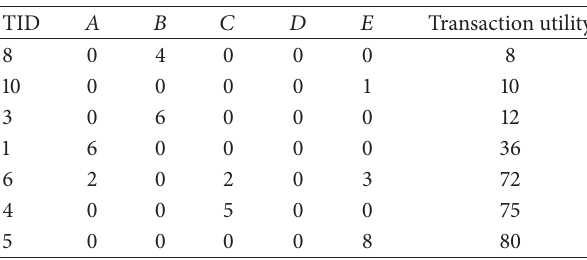
Table 8: The sorted candidate transactions for insertion.